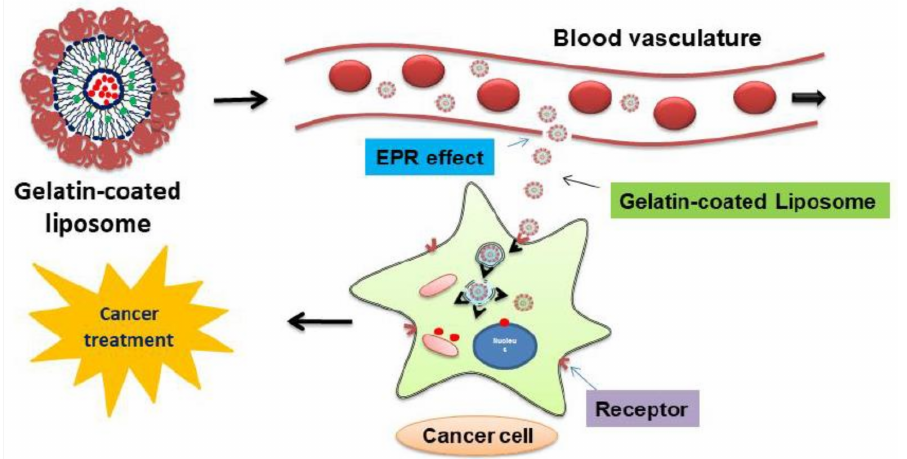
Figure 1. Summary of the cellular uptake of gelatin-coated